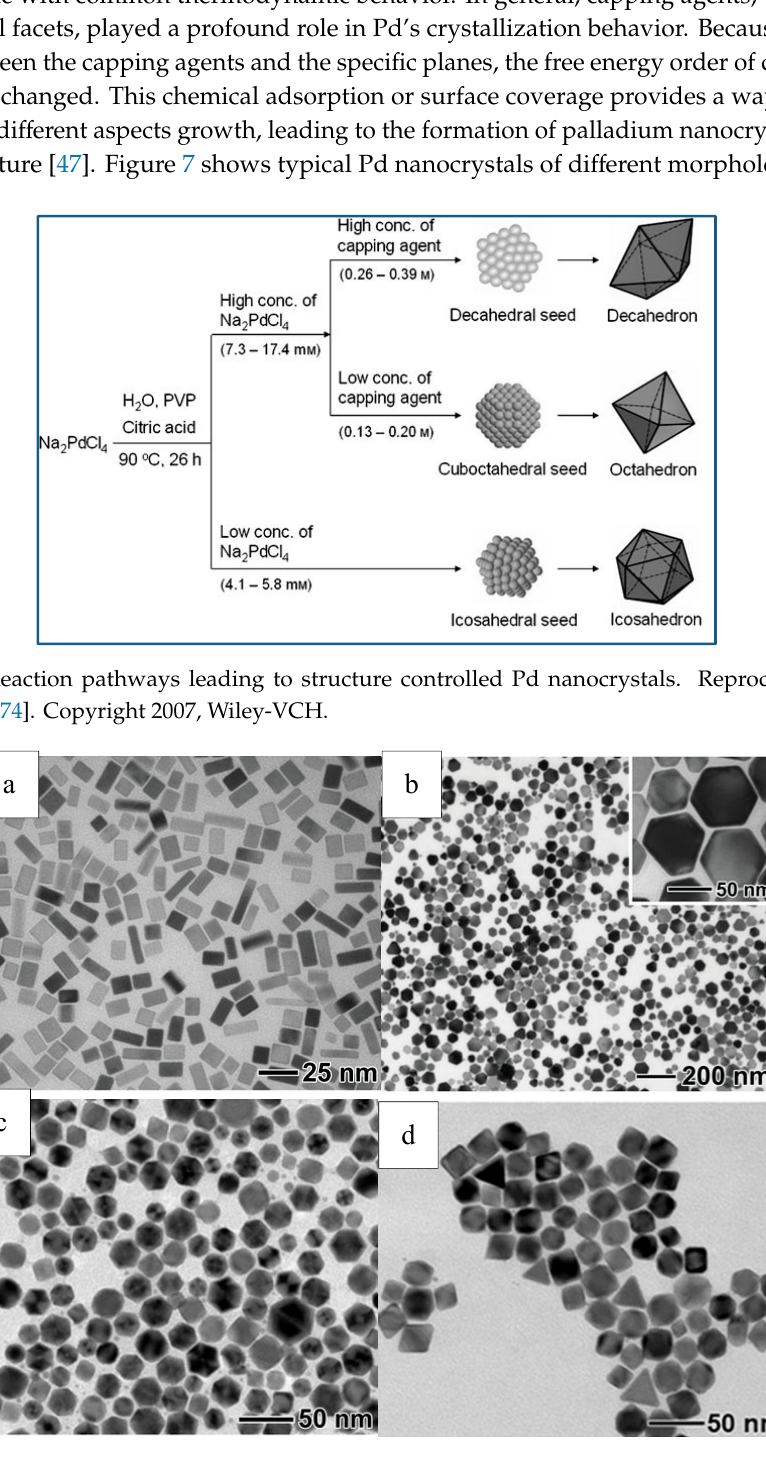
Figure 6. Reaction pathways leading to structure controlled Pd nanocrystals. Reproduced with